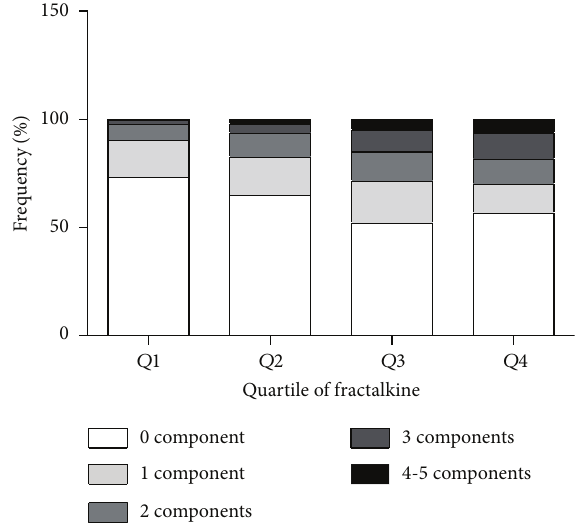
Figure 2: The number of MetS components plotted according to baseline fractalkine quartiles at year